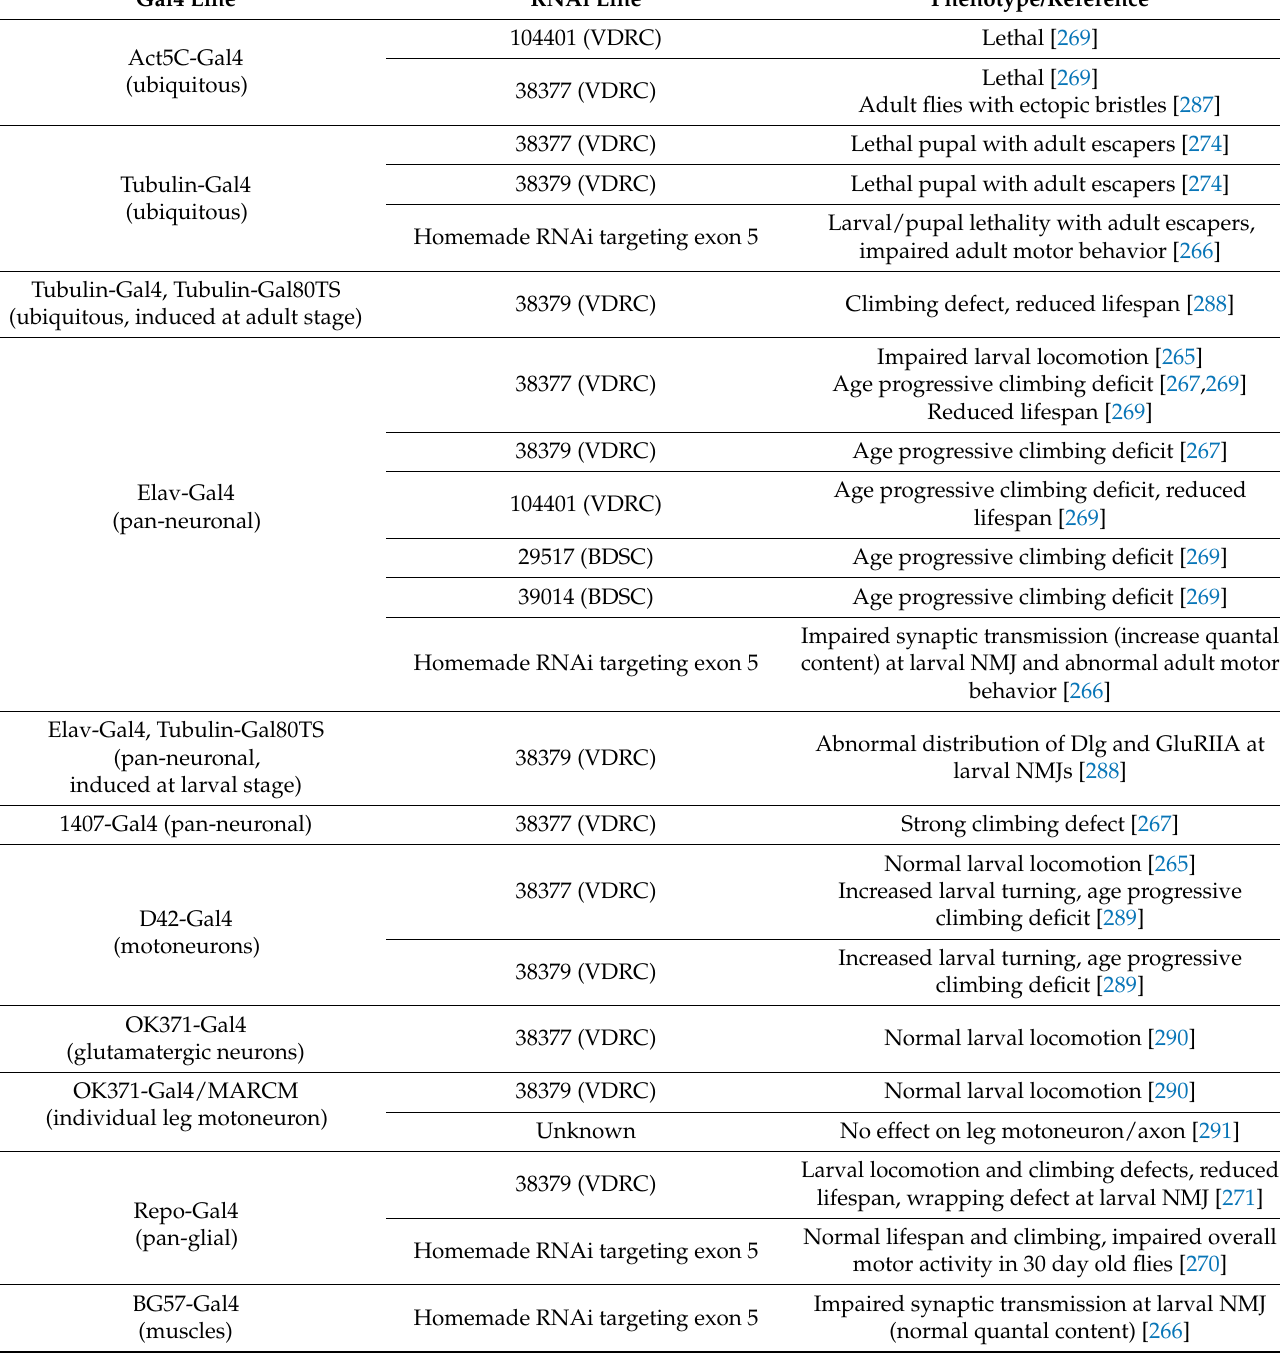
Table 8. Major phenotypes associated with RNA interference (RNAi)-induced TPBH silencing. Gal4